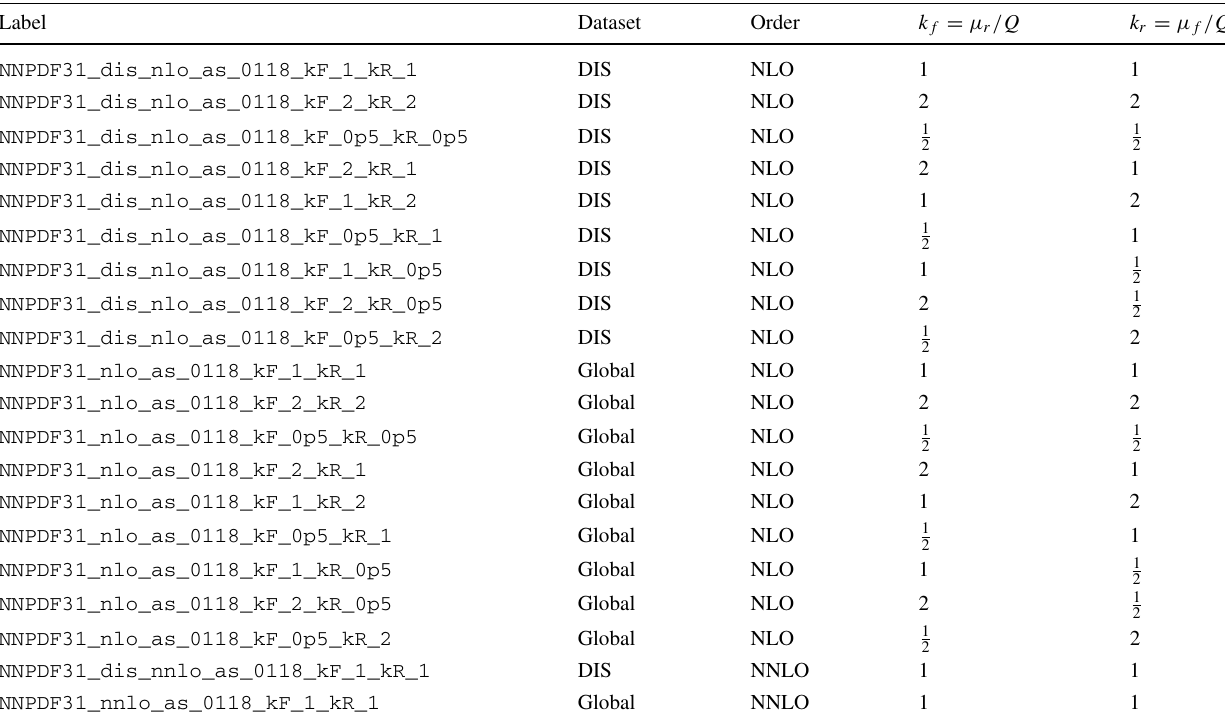
Table 13 List of PDF sets with different choices of the renormalization μ f and factorization μ f . For each set, we indicate its label, the input dataset, the perturbative order, and the ratios k r = μ r / Q and k f = μ f / Q to the central scale Q Label